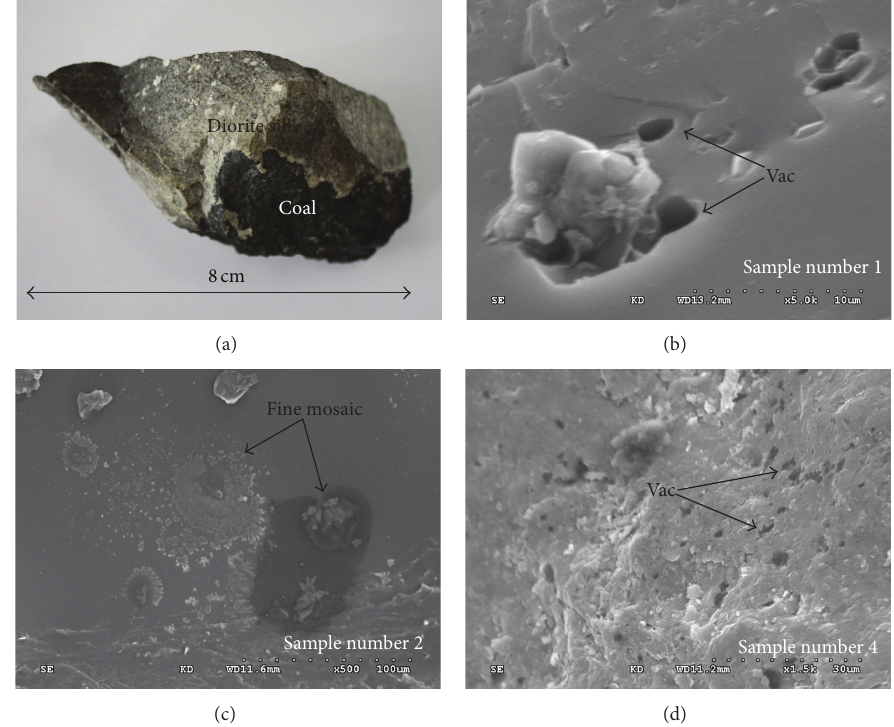
Figure 4: Macroscopic appearance of the igneous sills (a). Photomicrographs (b), (c), and (d) were obtained using SEM. Altered coal showing devolatilization vacuoles (vac), sample 1, 𝑅 𝑜 = 2.78 , magnification 5000x (b); altered coal showing fine mosaic texture, sample 2, 𝑅 𝑜 = 2.75 , 500x (c); altered coal showing (vac), sample 4, 𝑅 𝑜 = 2.69 , 5000x